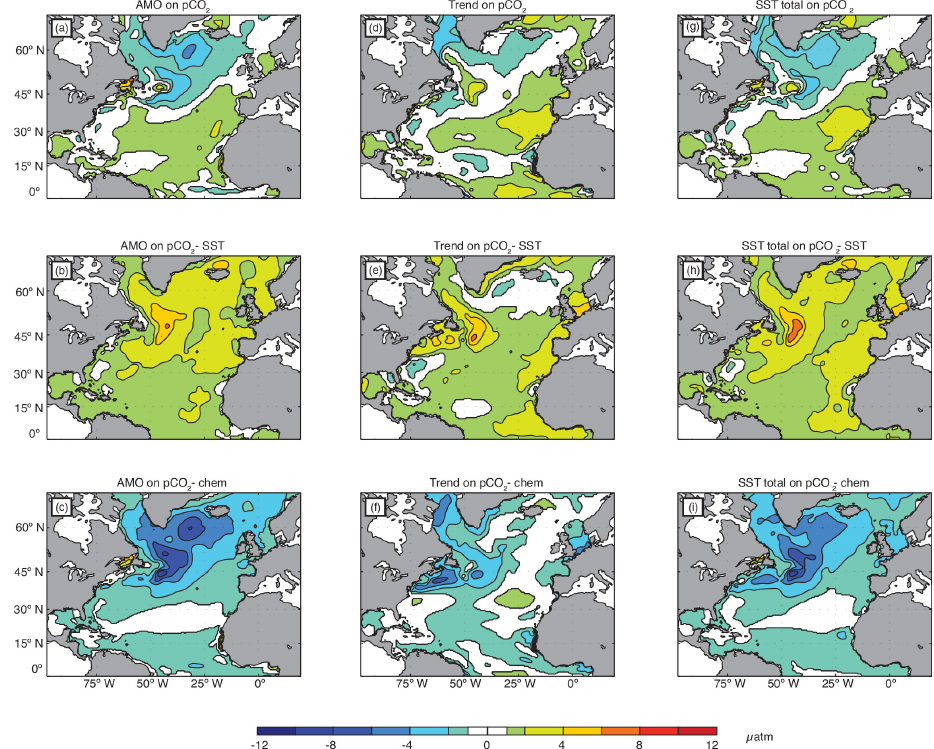
Figure 3. 121-month box-smoothed AMO regressed onto unsmoothed monthly (a) p CO 2 , (b) p CO 2 -SST, and (c) p CO 2 -chem. SST trend regressed onto (d) p CO 2 , (e) p CO 2 -SST, and (f) p CO 2 -chem. NASST (AMO + SST trend) regressed onto (g) p CO 2 , (h) p CO 2 -SST, and (i) p CO 2 -chem. Regressions calculated from 1953 through 2005. Values <0.5 and > − 0.5µatm are whited out to highlight regions experiencing the most substantial